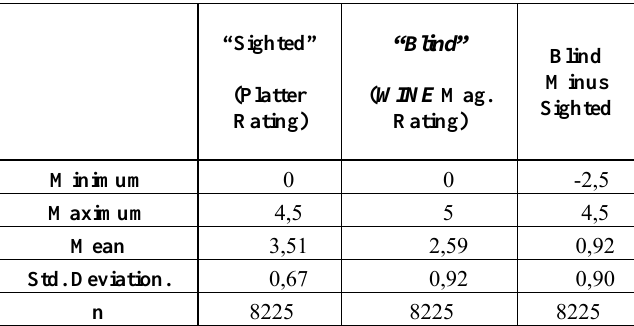
Table 2: Descriptive statistics of wine assessment